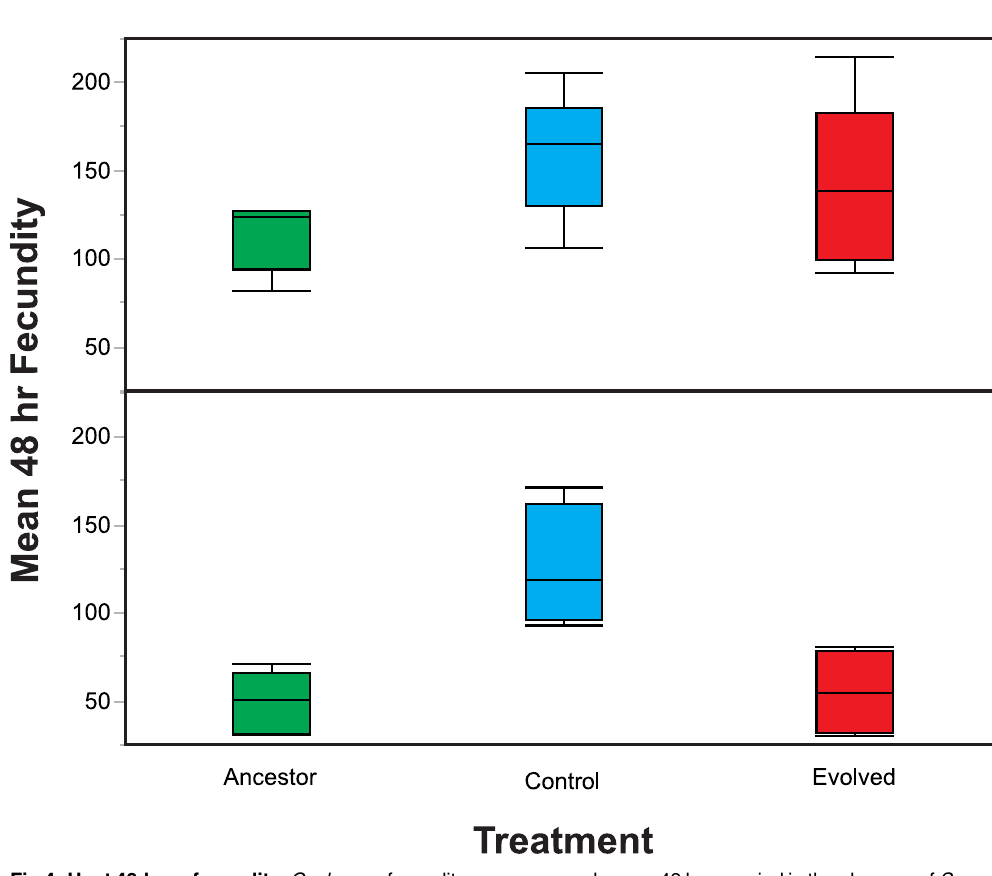
Fig 4. Host 48-hour fecundity. C . elegans fecundity was measuredover a 48 hour periodin the absenceof S . marcescens . Controlpopulationsexhibitedincreasedmean 48-hour fecundity in both the (A) mixed mating and (B) obligately outcrossingpopulations. Additionally,the mixed mating populationsexhibitedgreater mean 48-hour fecunditythan the obligatelyoutcrossing populations. https://doi.org/10.1371/journal.pone.0181913.g004 passaged in the presence of the live parasite evolved increased defense to the parasite, resulting in decreased mortality in the presence of the parasite in comparison to ancestral populations and populations passaged with heat-killed parasite (Fig 2). With regards to changes in fecun- dity, the populations passaged with heat-killed parasites evolved increased 48-hour fecundity (Fig 4). However, evolution under selection imposed by live parasites did not result in increased host fecundity or shifts in host reproductive timing, relative to the Control treat- ment, for either mixed mating or obligately outcrossing populations (Figs 3 and 4). Therefore, Table 4. ANOVA table for mean 48-hour